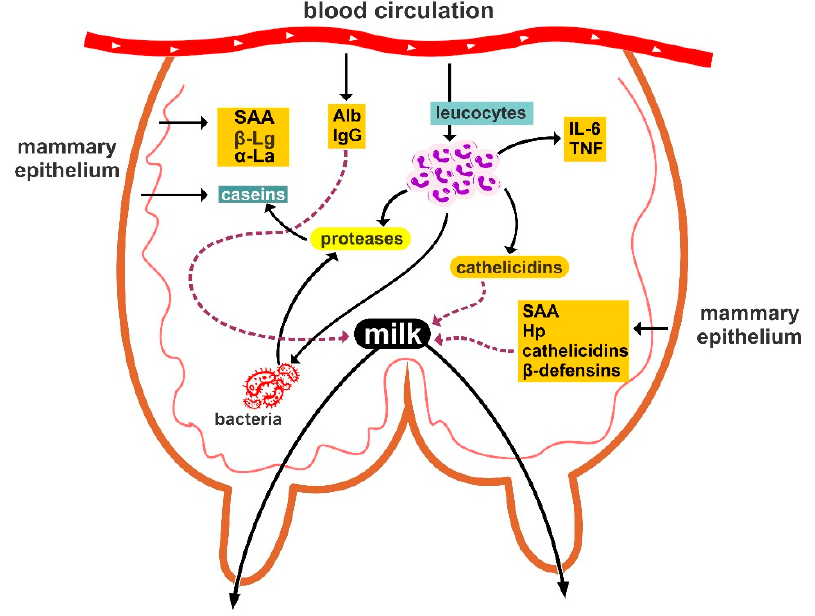
Figure 2. Graphic illustration of the main defensive mechanisms in the mammary gland of ewes.